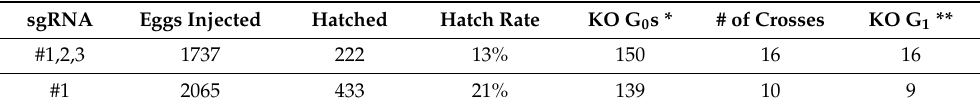
Table 3. CRISPR knock-out microinjections and knock-out rate for Ad vermilion gene in A. domesticus .